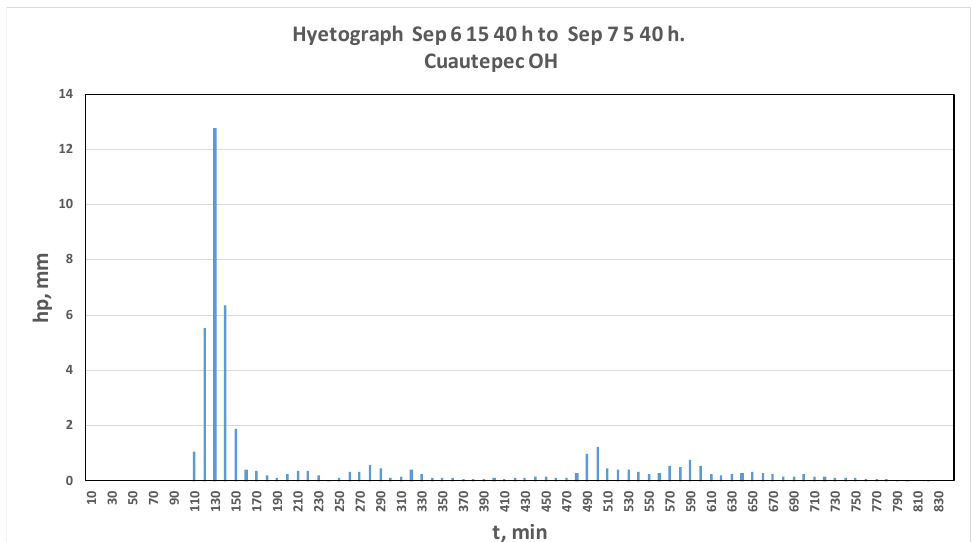
Figure 3. Flash flood hyetograph that occurred in September 2021 in Mexico State, Mexico. Journalistic sources highlighted at least 2 deaths, nearly 100,000 affected inhabitants, and material damage in 19 different